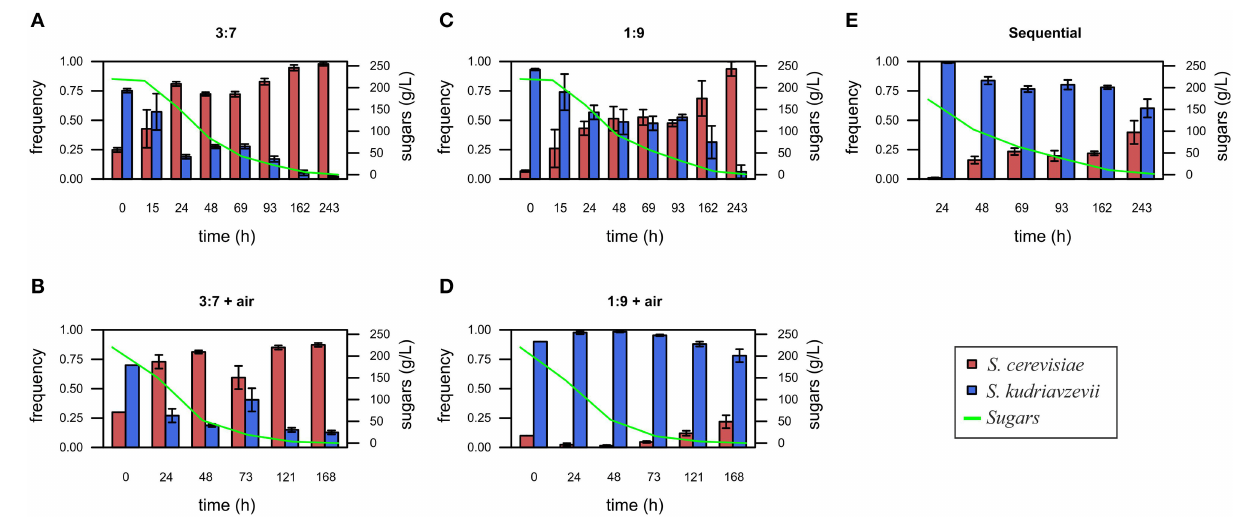
FIGURE 2 | Saccharomyces cerevisiae and S. kudriavzevii frequency during fermentation under different conditions: inoculum proportion 3:7 without air (A) , inoculum proportion 3:7 with aeration during the first 48h (B) , inoculum proportion 1:9 without air (C) , inoculum proportion 1:9 with aeration during the first 48h (D) , and sequential inoculation (E) . Values are mean for 3 replicates. Error bars represent standard deviations. The sum of glucose and fructose concentrations in the must at every time point was also shown.